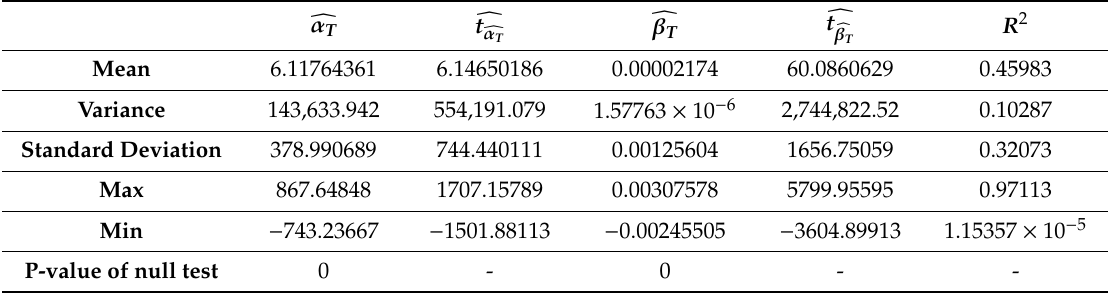
Table 1. Summary of the simulation results, with a sample size of T = 1,000,000.